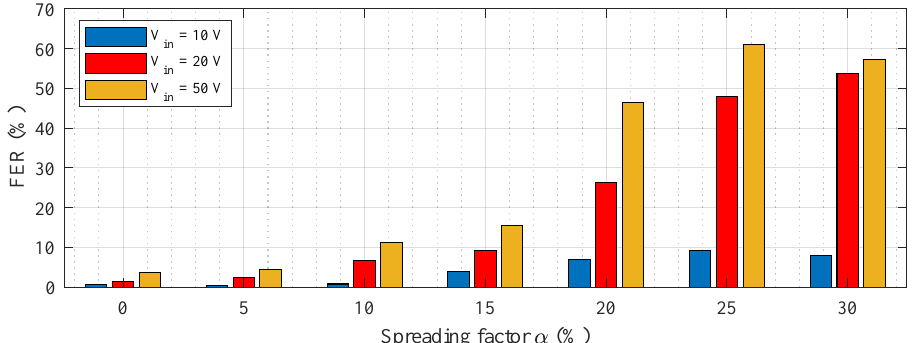
Figure 8. The PLC channel FER evaluation in the case of SSM EMI with several amplitudes and spreading factors α .